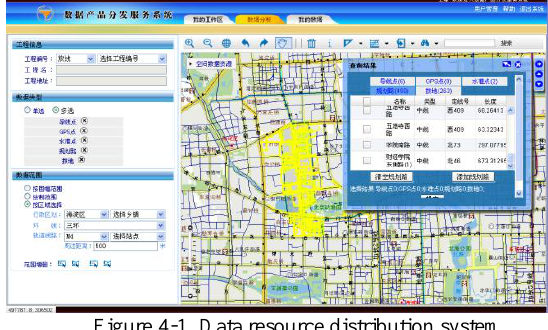
Figure 4-1. Data resource distribution